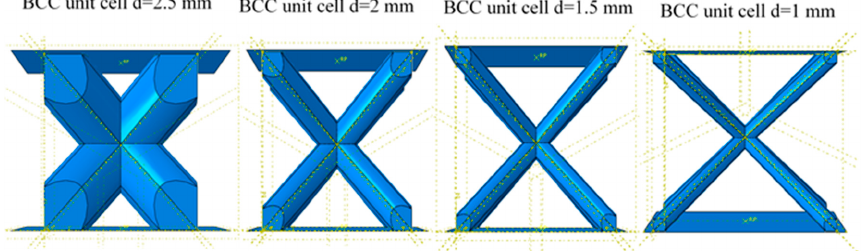
Figure 2. Various unit cell diameter for body centered cubic (BCC) configuration at 𝑥 (cid:3404) 𝑦 (cid:3404) 𝑧 (cid:3404) 5 mm.